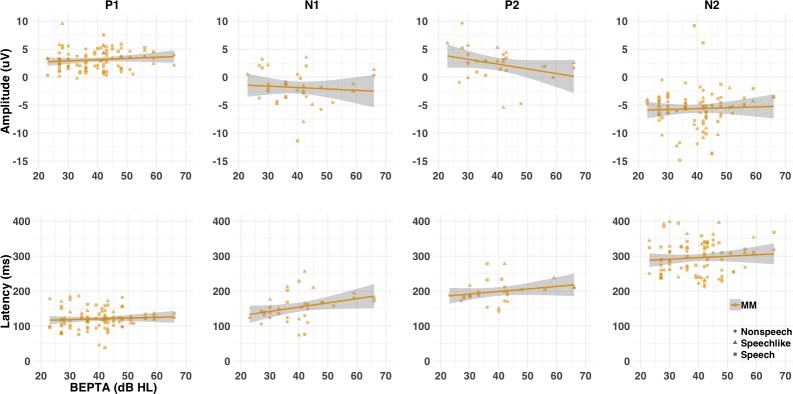
Amplitude (μV) and latency (ms) of LAER components (P1, N1, P2, and N2) for the MM group as a function of severity of hearing loss (cross-sectional study).Individual (shapes) and group (lines) data are shown for each condition (nonspeech = circles; speech-like = triangles; speech = squares) and component. Shaded lines represent the 95% confidence interval. Worse BEPTA thresholds were associated with smaller P1 amplitudes in the speech-like condition, and later N1s across conditions, where present.